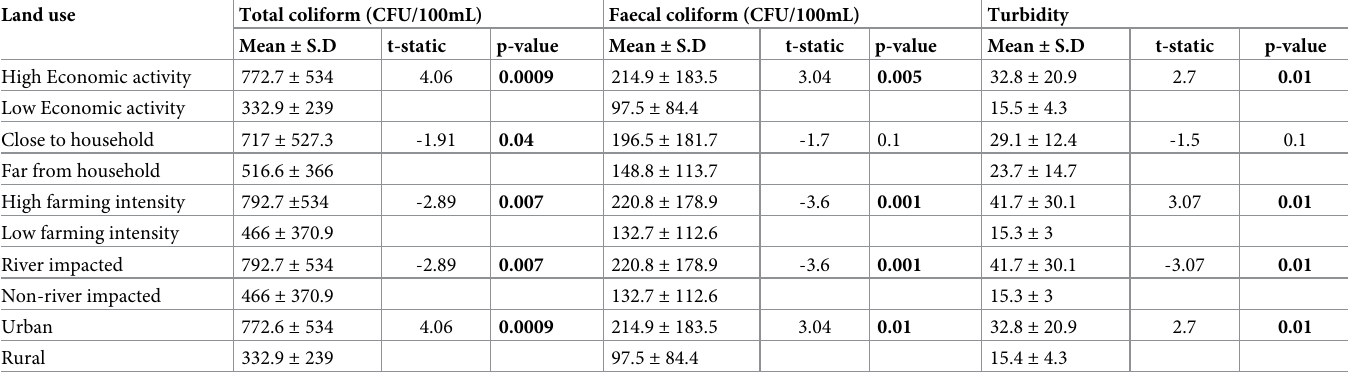
Table 4. t-Test: Paired two sample for means showing the monthly mean ± Standard Deviation (S.D) of potential drivers influencing concentration of coliform and turbidity in the study sites separated by different characteristic, t-static and p-value at 0.05. The variables which were significant are bolded. Land use